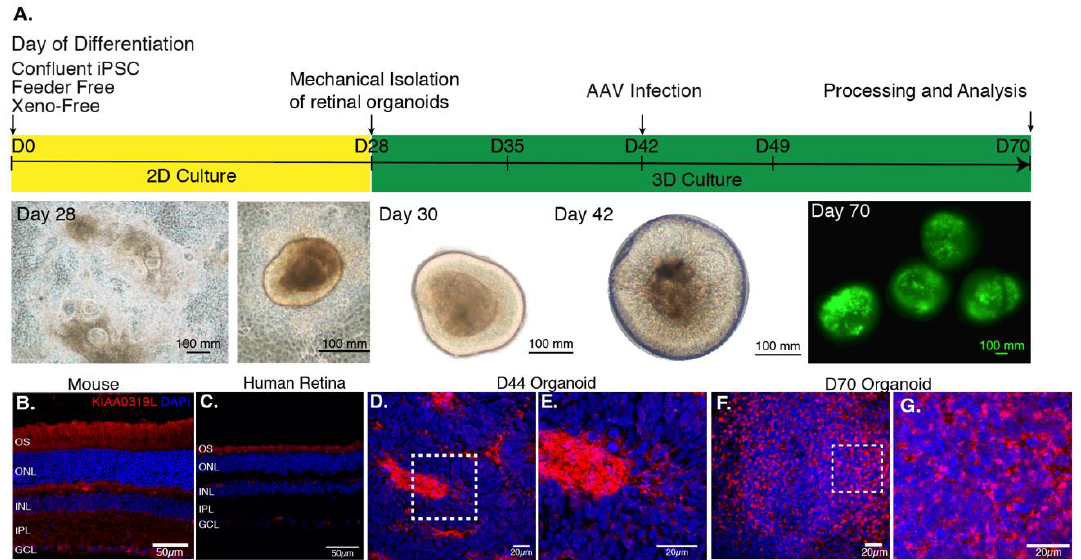
Figure 2. ( A ) AAV-mediated gene delivery to retinal organoids. Schematic of the protocol for generating and infecting human retinal organoids with representative images from each step. rAAV infection is performed at day 44 of differentiation. The efficiency of gene delivery illustrated on day 70 corresponds to one-single infection using AAV2-7m8-GFP at a dose of 5 × 10 10 vg per organoid. ( B ) Expression of AAV receptor KIAA0319L in mature mouse retina, human retina and hiPSC-derived organoids. Representative retinal cross-section of wild-type mouse ( B ) or human retina ( C ) stained with antibodies against the KIAA0319L receptor. ( D ) Expression of AAVR KIAA0319L in Day 44 old hiPSC-derived organoids. ( E ) Zoom into the dotted square depicted in D. ( F ) Expression of AAVR KIAA0319L in day 70 old hiPSC-derived organoids. ( G). Zoom into the dotted square depicted in F. Scale bars: A and D = 50 μm; B–C; E–F = 20 μm.